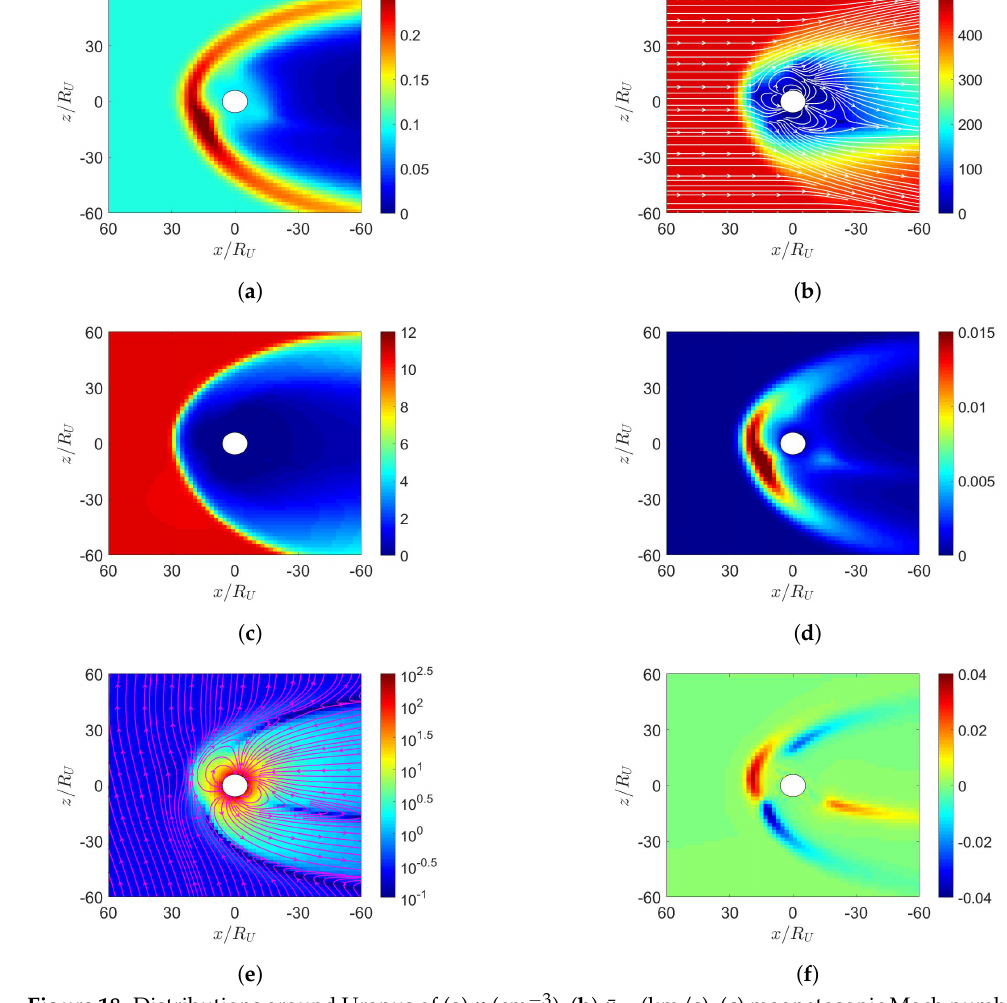
Figure 18. Distributions around Uranus of ( a ) n (cm − 3 ), ( b ) ¯ u xz (km/s), ( c ) magnetosonic Mach number, ( d ) P (nPa), ( e ) B ( nT ) , ( f ) J y (nA/m 2 ); initial dipole tilts down and towards the sun, northward IMF, t = 85.4